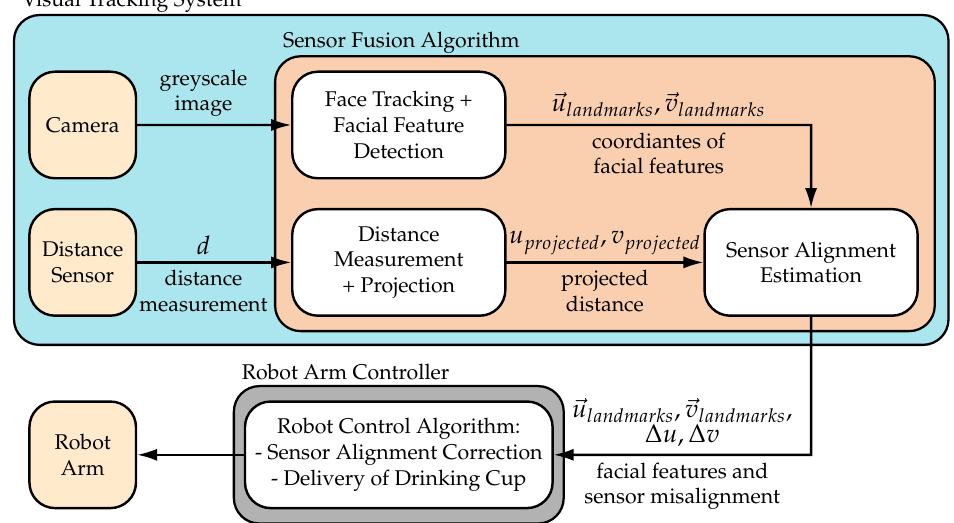
Figure 3. Block diagram showing the components of the robotic system for autonomous assistive drinking. The robotic system includes the robot arm, visual tracking system, and robot controller. The tracking system consists of the two hardware sensors and three software components. Another necessary component is the sensor alignment correction of the robot arm controller which together enable robust localization of the mouth.